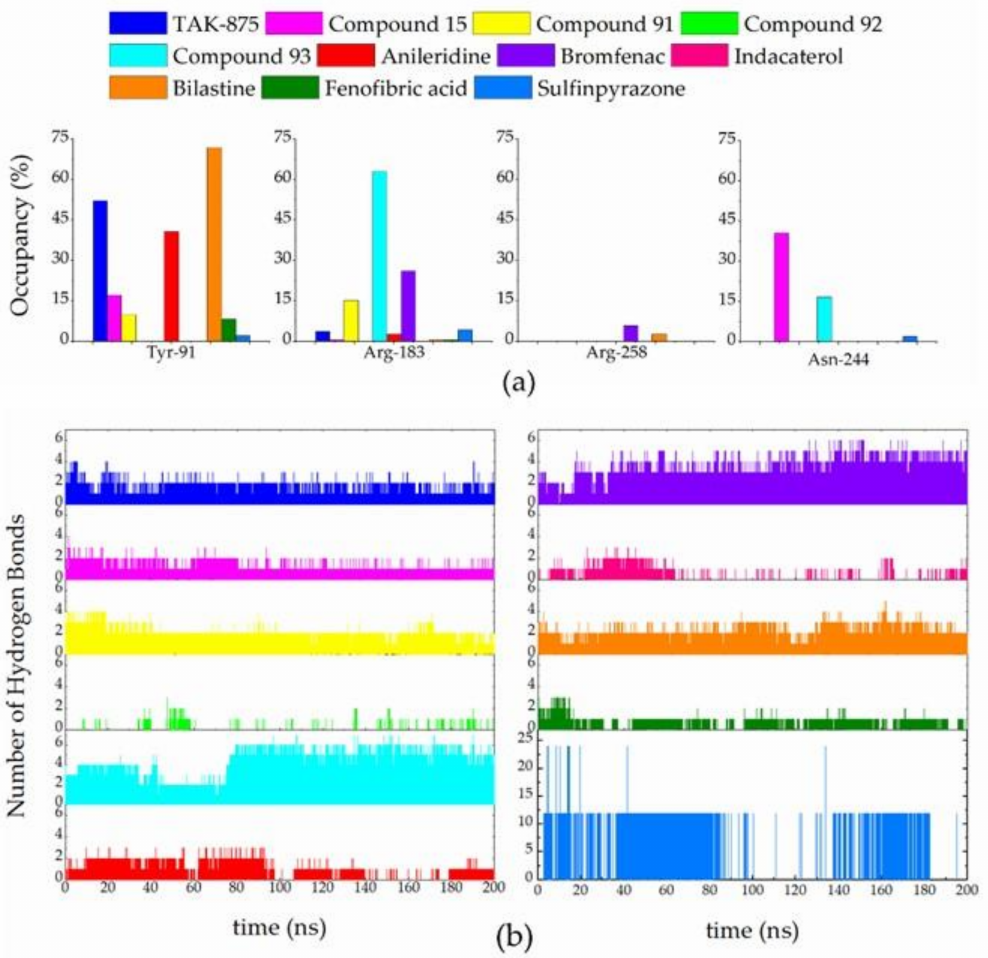
Figure 9. ( a ) Occupancies and ( b ) number of hydrogen bonds between FFA1 and the studied compounds during the 200 ns